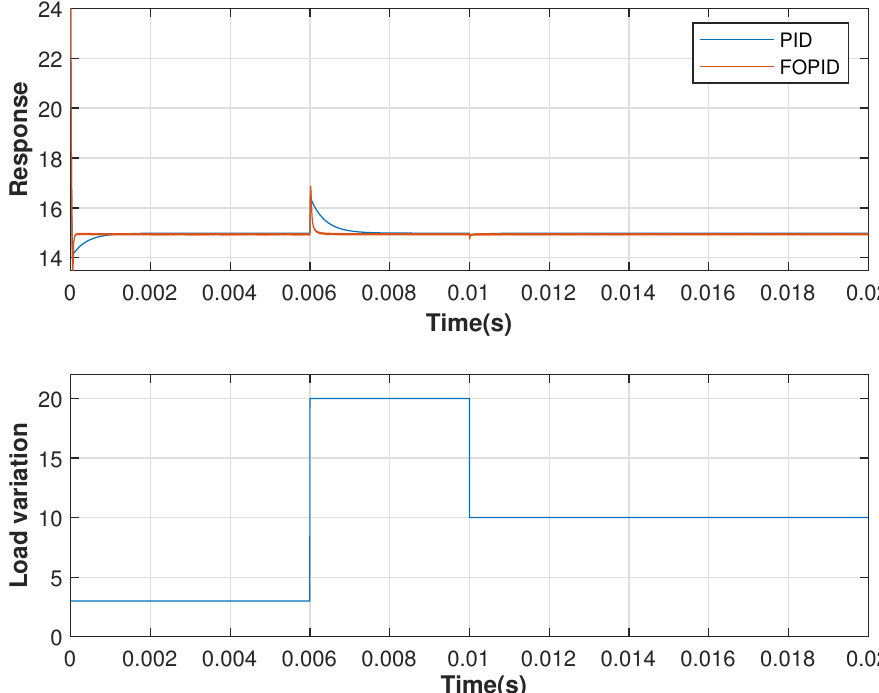
Figure 11. Dynamic Response of CI-ISE optimized system to step-load variation.